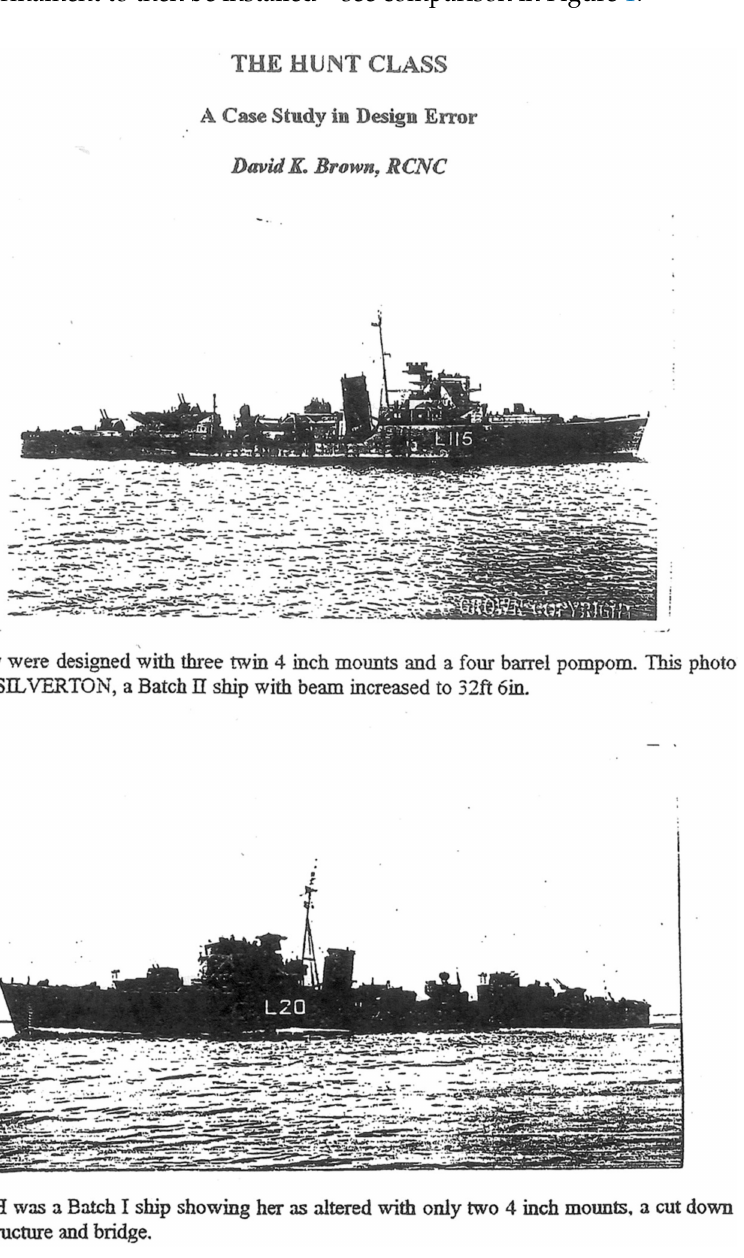
Figure 1. Comparison of 1938 HUNT Class Batch I and Batch II